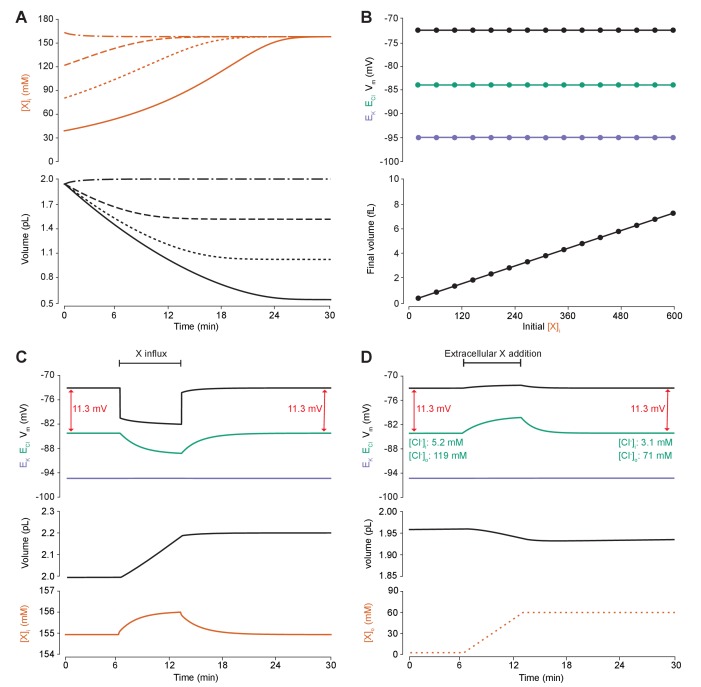
Adding intracellular or extracellular impermeant anions, without changing the mean charge of impermeant anions, does not affect the steady state gradient or driving force for chloride.(A) Initiating the model with different starting concentrations of intracellular impermeant anions ([X]i) with the same mean charge z = −0.85 (orange, top panel), led to compensatory volume changes (bottom panel) which resulted in identical steady state concentrations. (B) Steady state ECl (green), EK (purple) and Vm (black) were identical regardless of initial [X]i. Final volume, however, was a linear function of initial [X]i (bottom panel). (C) Addition of impermeant anions of the mean charge (z = −0.85) caused transients shifts in ECl (green, top panel), EK (purple), Vm (black) as well as [X]i (orange, bottom panel) for the duration of the influx, and sustained increases in volume (black, middle panel). No persistent changes in ECl, EK or Vm were observed. The full time-dependent ionic and water fluxes for the experiment are shown in Figure 4—figure supplement 1, which shows that the inward flux of impermeant anions causes fluxes of all other ions. (D) Similarly, the addition of extracellular impermeant anions in an osmoneutral manner causes transient shifts in the permeable ion gradients (top panel, colours as in ‘C’), and sustained changes in cellular volume (black, middle panel) as well as the extracellular X and extracellular and intracellular Cl- concentrations.